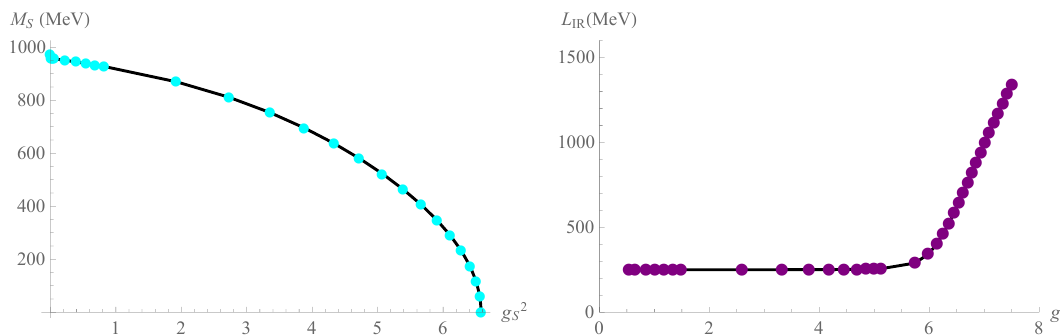
Figure 6. The instability of the massless embedding in the presence of an NJL interaction: on the left we show the mass of the σ scalar in the massless background of figure 1 (shown in red there) — it becomes tachyonic beyond a critical value of g 2 . On the right we show the IR quark mass L IR s against the NJL coupling as interpreted from the embeddings with a source in figure 1. We see that the tachyon instability is related to the NJL interaction changing the vacuum by enhancing chiral symmetry